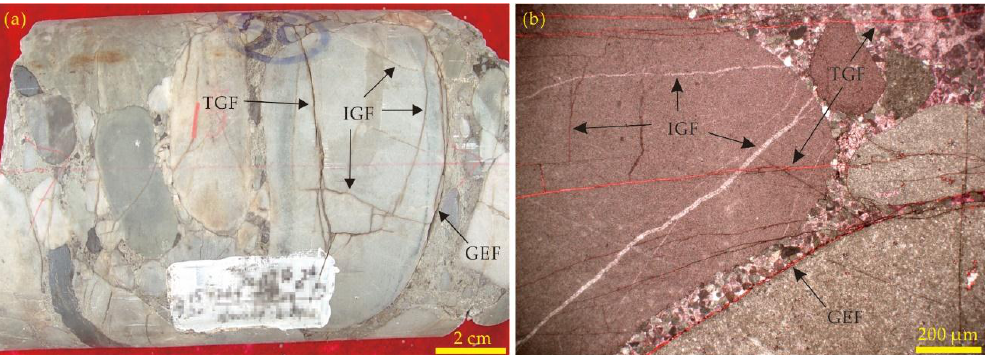
Figure 4. Fracture types in the tight conglomerates. ( a ) Well L4, 3164.32 m; ( b ) Well L102, 3198.35 m. IGF = intra-gravel fracture, TGF = trans-gravel fracture, GEF = Gravel edge fracture.